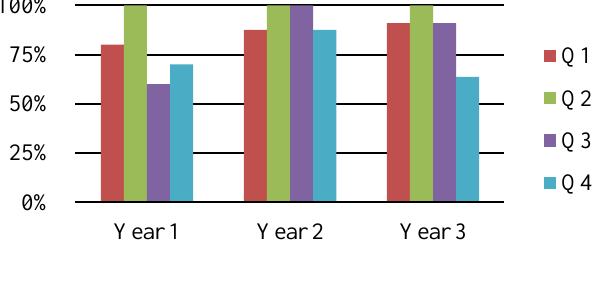
Figure 11. Student survey